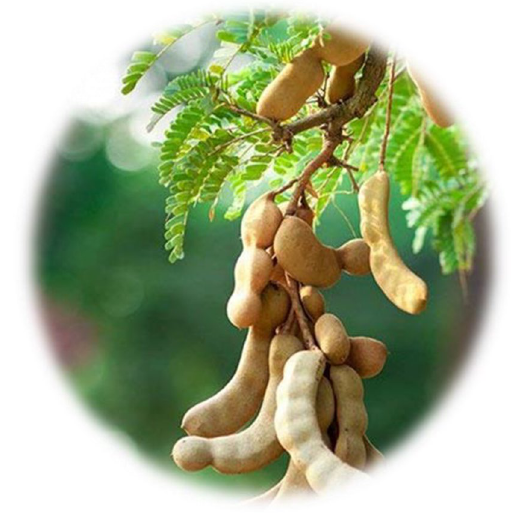
Fig. 23 Seed gums of Tamarindus indica as a